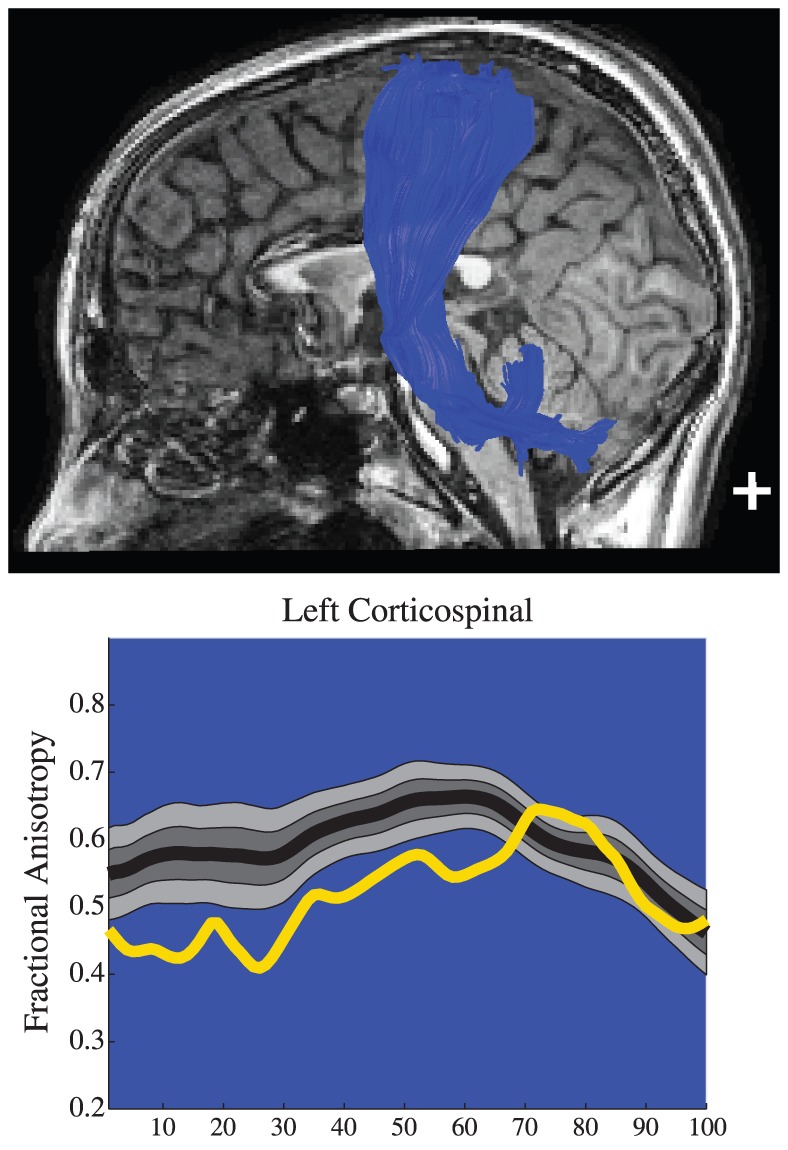
T1 images, tractography results and Tract FA Profiles for Patient 2, a child with cerebral palsy.In the plots, the black line represents the mean FA for typically developing children at 100 points along the tract and light gray region represents the boundaries for the 10th to 90th percentile. The yellow line represents the patient's FA along the tract. The patient has low FA along the corticospinal tract.